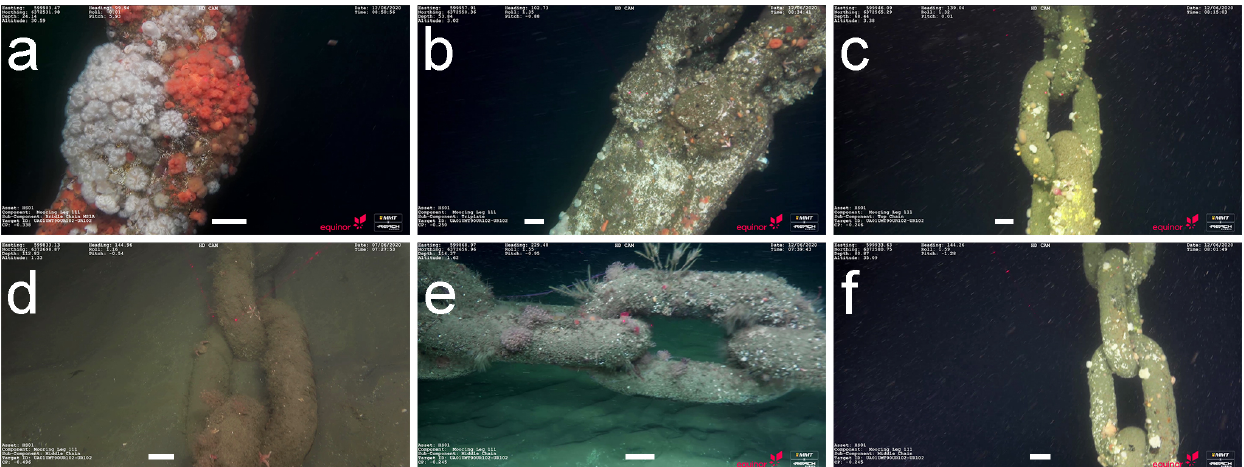
Figure 7. Example images along a typical mooring line (mooring line 111 of turbine HS01) from top to bottom. (a) Top chain, bridle chain. (b) Top chain, triplate. (c) Top chain. (d) Middle chain, on the seabed. (e) Middle chain, off the seabed. (f) Middle chain. Scale bar: